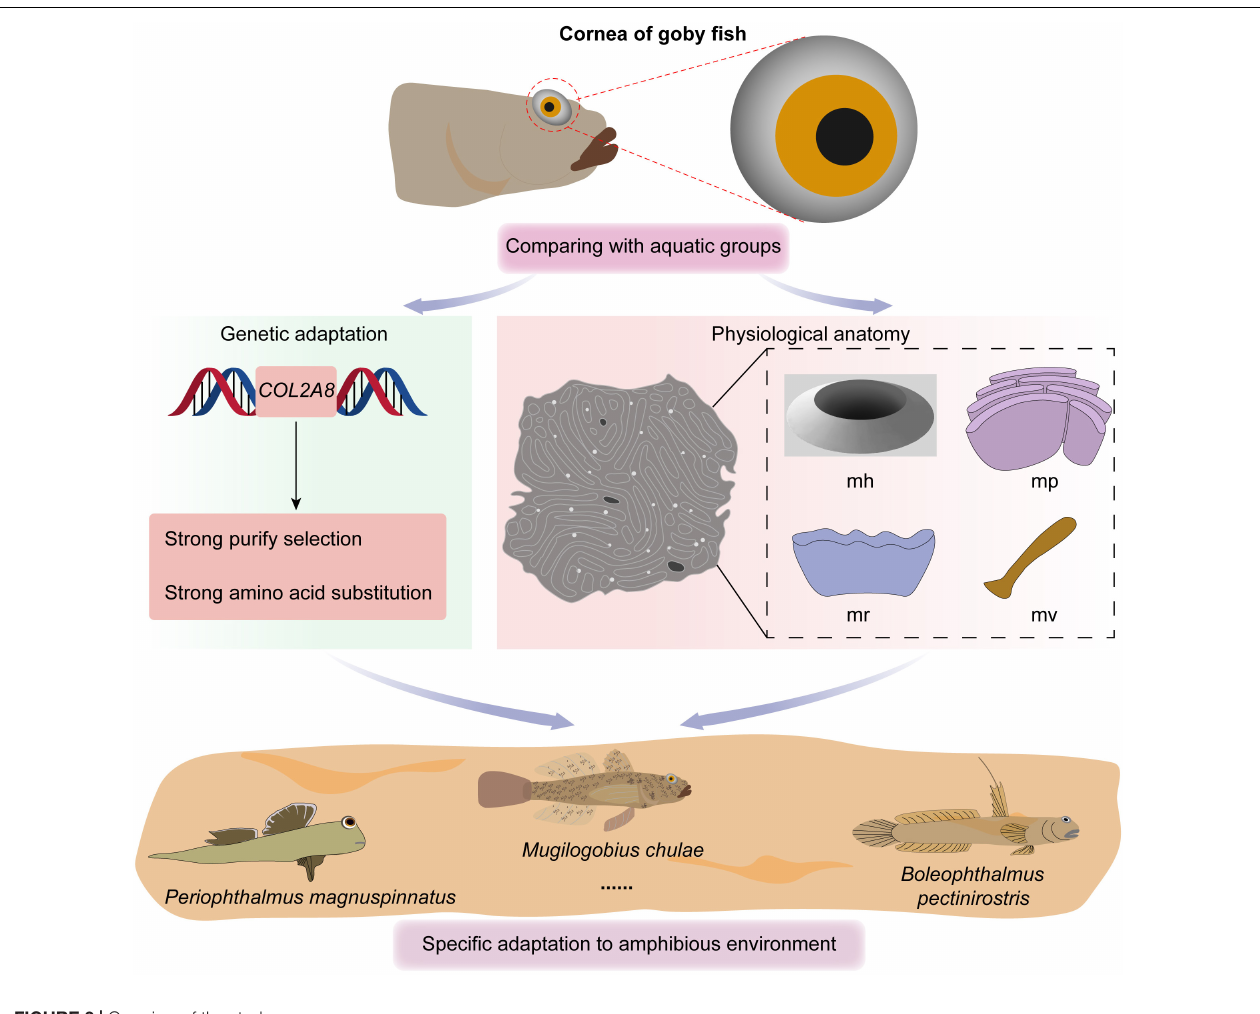
FIGURE 3 | Overview of the